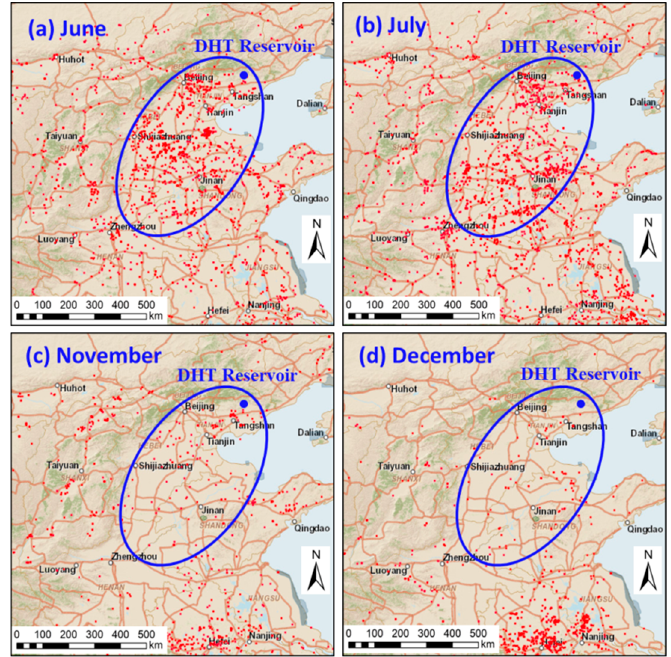
Figure 5. Fire pixel counts in North China observed from MODIS Terra and Aqua [62] in ( a ) June, ( b ) July, ( c ) November, and ( d ) December 2019.